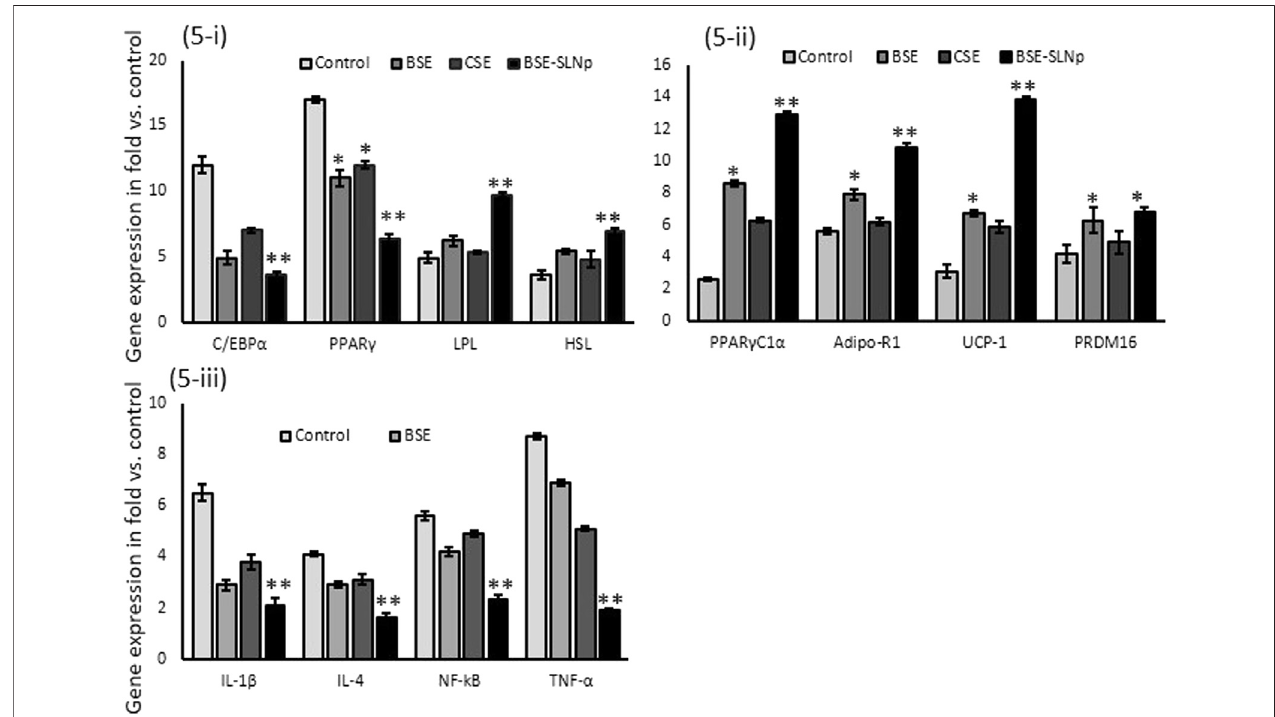
FIGURE 5 | Effect of BSE, CSE, and BSE-SLNp on adipogenic (5i) , mitochondrial thermogenesis (5ii) , and metabolic in fl ammation (5iii) related gene expression levelsinmaturingadipocyteafter14 days.Eachvalueismeans ± SD( n (cid:2) 6).* p ≤ 0.05bycomparisonwithvehiclecontrol.** p ≤ 0.001bycomparisonwithvehiclecontrol, BSE, and